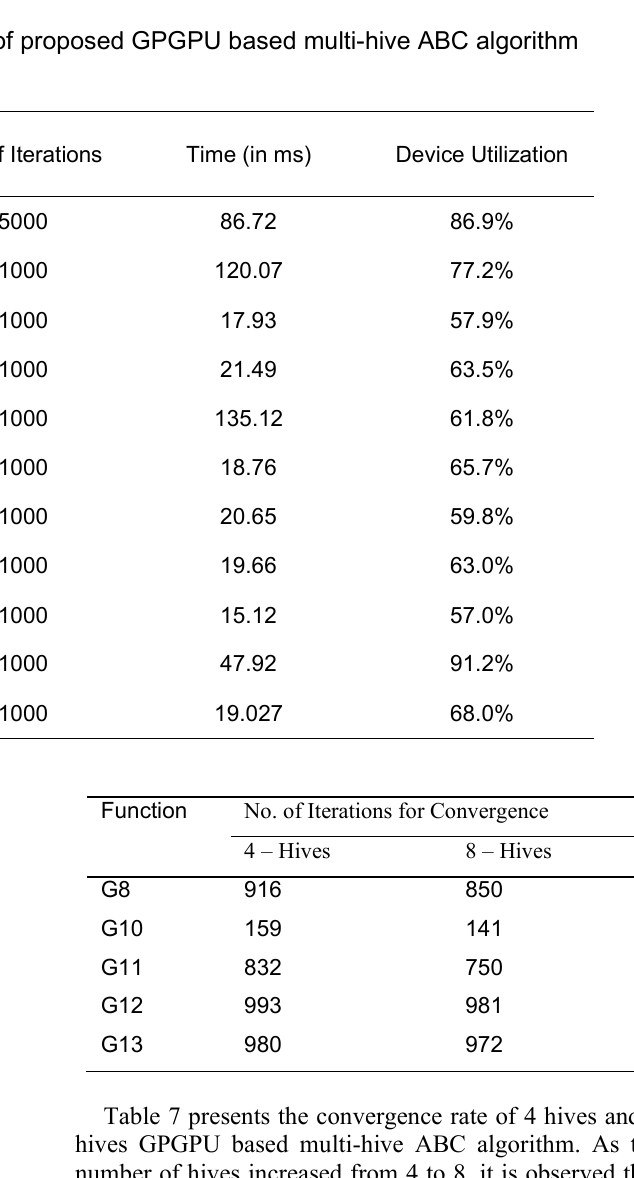
Table 6. Execution time and Device utilization of proposed GPGPU based multi-hive ABC algorithm